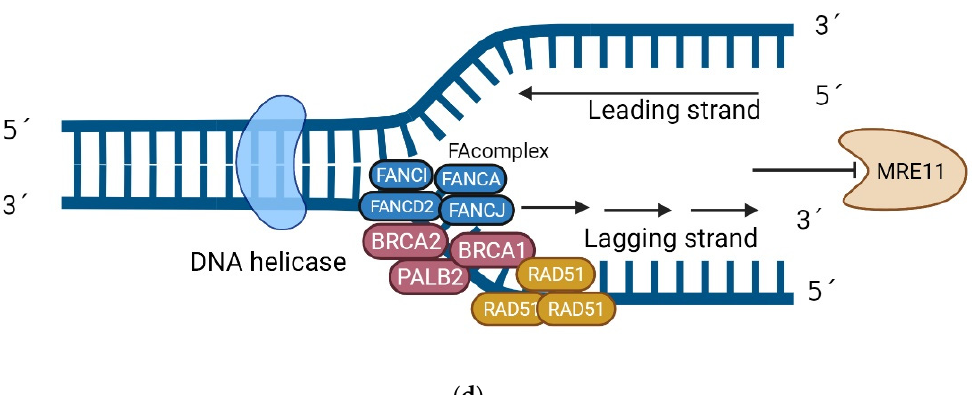
Figure 3. Distinct functions of BRCA1 and BRCA2 in ( a ) homologous recombination (HR) repair, ( b ) DNA damage cell cycle checkpoint, ( c ) R-loop processing and transcription, and ( d ) DNA replication fork protection.